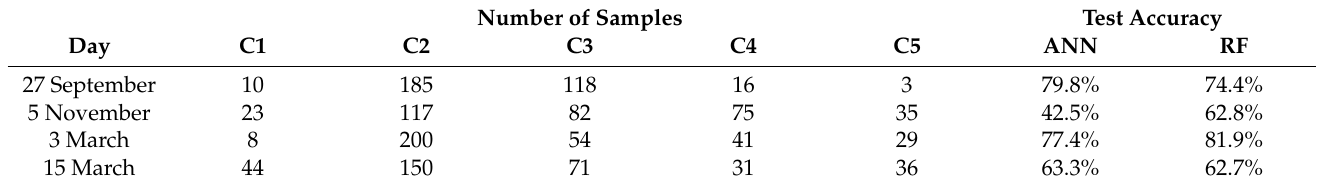
Table 7. Performance and class composition of the days selected for the performance comparison. Number of